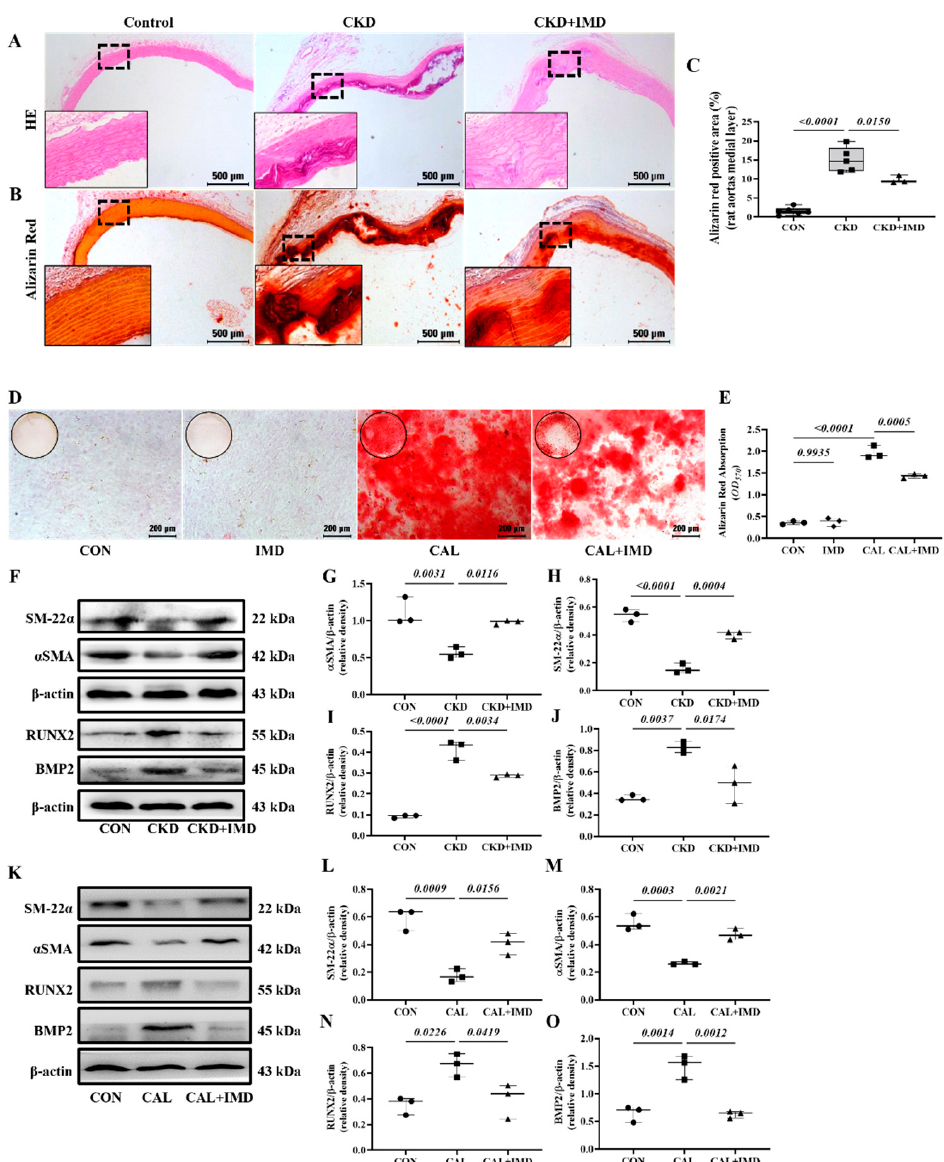
Figure 1. IMD alleviated vascular calcification in CKD rats and calcification of VSMCs. ( A ) H&E staining (Scale bar = 500 µ m) and ( B ) Alizarin red staining for calcium deposition (positive staining: red) (Scale bar = 500 µ m) in rat aortas. ( C ) Quantification of alizarin red-positive staining ( n = 3–6). ( D ) Alizarin red staining (positive staining: red) (Scale bar = 200 μ m) of calcified rat VSMCs and ( E ) quantification ( n = 3). ( F ) Western blot analysis of the protein levels of smooth muscle 22 alpha (SM22 α ), alpha smooth muscle actin ( α SMA), bone morphogenetic protein 2 (BMP2) and runt-related transcription factor 2 (RUNX2) in rat aortas and ( G – J ) quantification ( n = 3). ( K ) Western blot analysis of the protein levels of SM-22 α , α SMA, BMP2 and RUNX2 in rat VSMCs and ( L – O ) quantification ( n = 3). CON (circles): control rats or VSMCs, CKD (squares in ( C , G – J )): CKD vascular calcification rats, CKD + IMD (triangles in ( C , G – J )): CKD vascular calcification rats with IMD 1-53 treatment, IMD (diamonds in ( E )): control VSMCs with IMD 1-53 treatment, CAL (squares in ( E , L – O )): calcification VSMCs, CAL + IMD (triangles in ( E , L – O )): calcification VSMCs with IMD 1-53 treatment. Data are mean ±